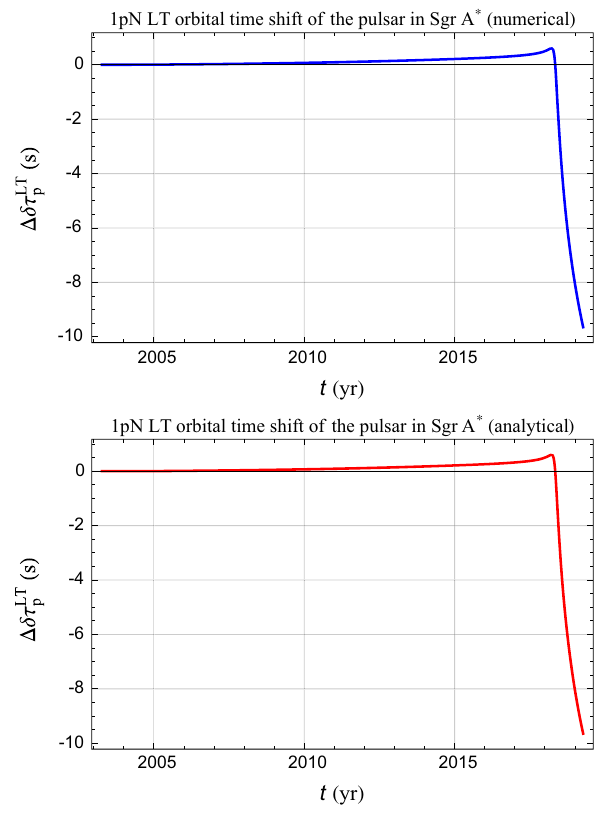
Fig. 2 Upper row , blue curve (cid:2)δτ LT p ( t ) , in s, of a hypothetical pul- sar in Sgr A ∗ as the outcome of the difference between two numerical integrations of the equations of motion in Cartesian coordinates over a time span ranging from, say, t 0 = 2003 . 271 to t 0 + P b . Both the inte- grations have the same (Keplerian) initial conditions for f 0 = 139 . 72 ◦ , corresponding to t 0 = 2003 . 271, and differ by the 1pN gravitomagnetic acceleration, which was purposely switched off in one of the two runs. Lower row , red curve (cid:2)δτ LT p ( t ) , in s, of a hypothetical pulsar in Sgr A ∗ obtained analytically from Eqs. (26) to (27) and the instantaneous changes of the Keplerian orbital elements, not displayed in the text, induced by Eq. (42). It turns out that the net shift after a full revolu- (cid:4) (cid:3) = − 9 . 6439 s. The (cid:2)δτ LT tion starting at t 0 = 2003 . 271 amounts to p orbital configuration of the S2 star, quoted in Table 1, was adopted for the putative pulsar in Sgr A ∗ along with i • = 20 . 9 ◦ , ε • = 317 . 9